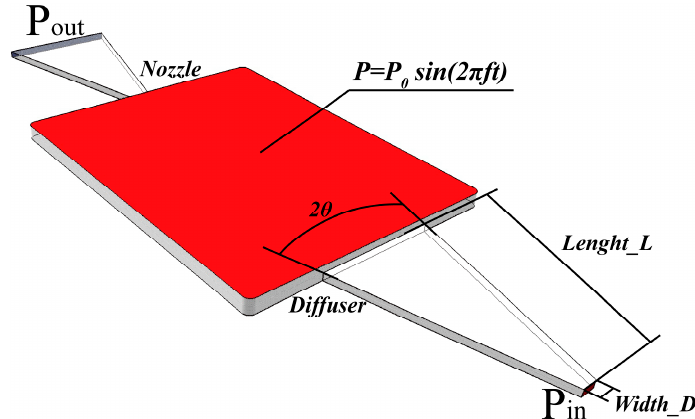
Figure 1. Parameters of the design of the air pump chamber.